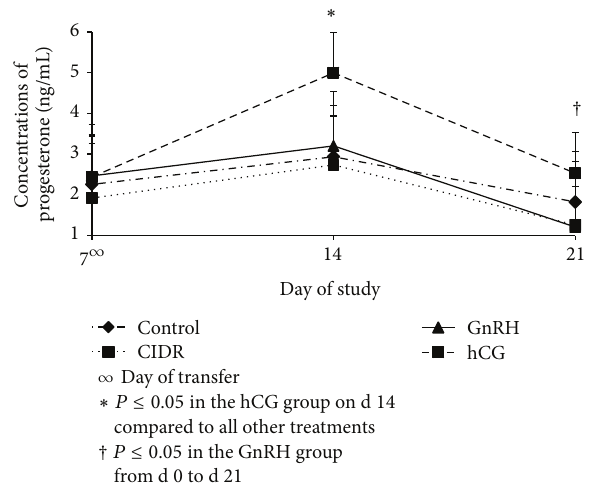
Figure 2: Concentrations (Mean ± SEM) of progesterone among treatment groups on d 7, d 14, and d 21. Treatment by day, concentrationofprogesteronedecreasedincowsfromalltreatments from d 14 to d 21 (𝑃 ≤ 0.05) ; CIDR = controlled drug release; GnRH = gonadotropin releasing hormone; hCG = human chorionic